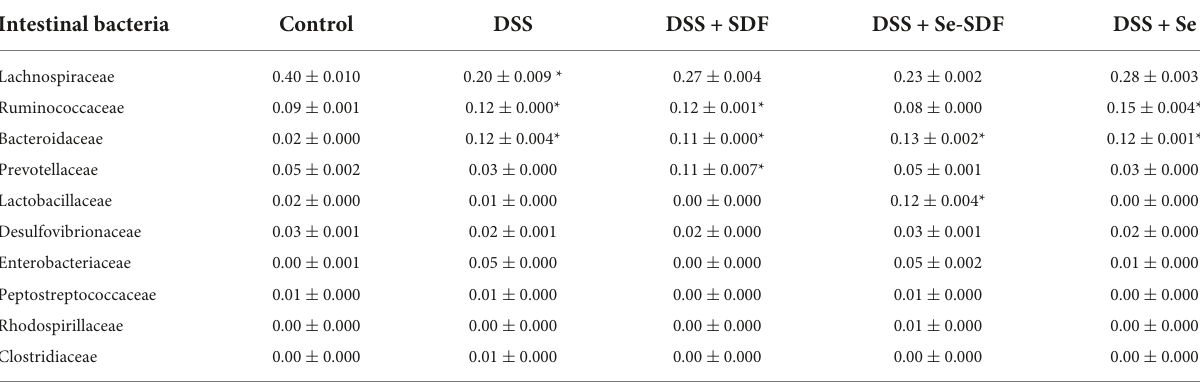
TABLE 1 Abundance of intestinal